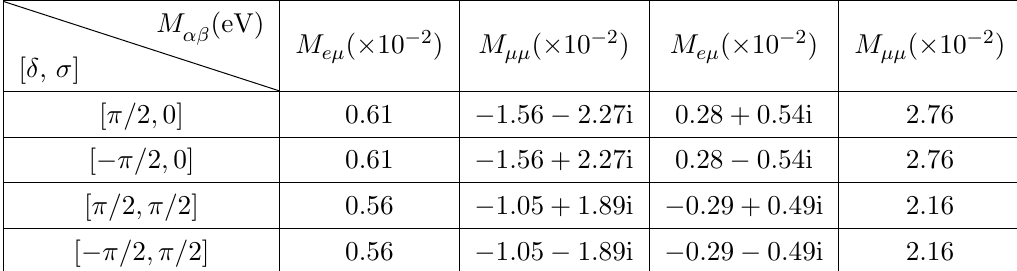
Table 3 . The possible values of M after one of them is made real by a particular value of (cid:30) .